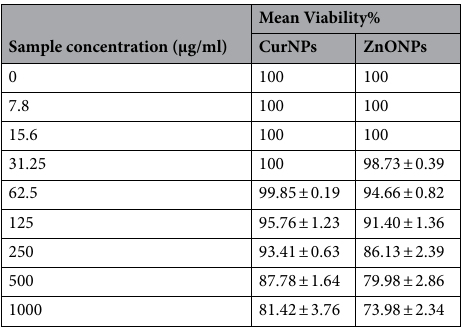
Table 1. Evaluation of cytotoxicity of CurNPs and ZnONPs against rat hepatocytes cell line by MTT assay. Values are expressed as mean ± SEM.